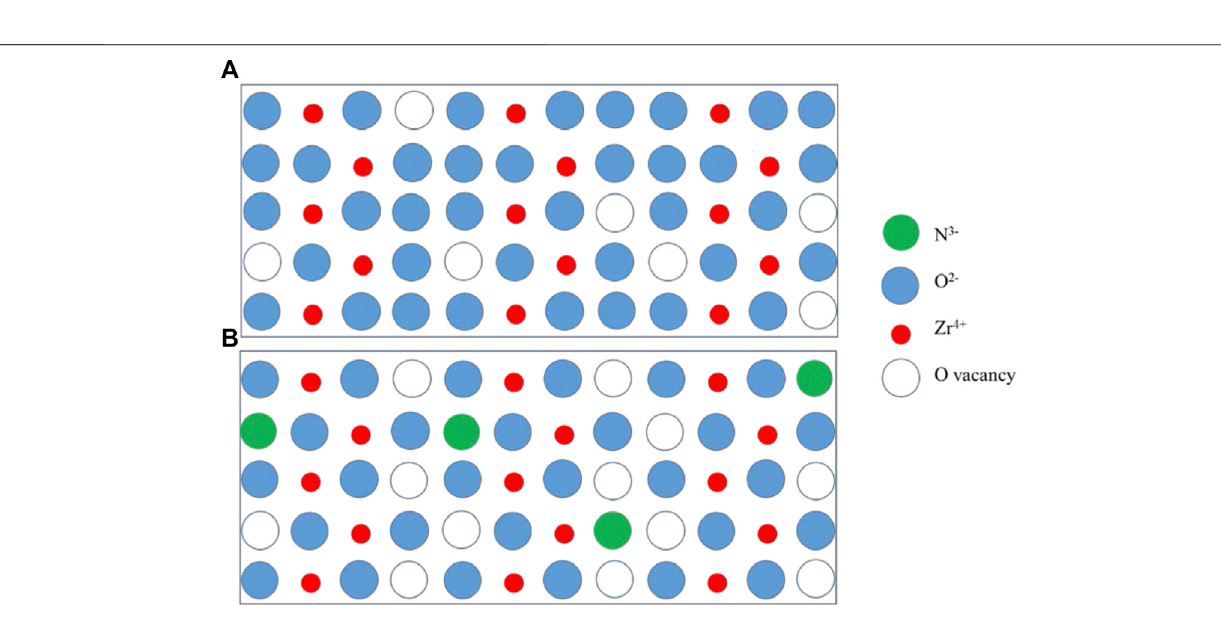
FIGURE 9 | Schematic of mechanism of the NH 3 accelerating corrosion rate of the Zr alloy. (A) in the environment without NH 3 (B) in the environment with NH 3 .